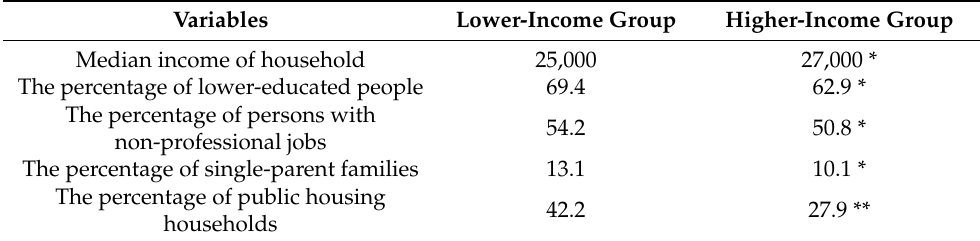
Table 4. Comparison of exposure index between lower- and higher-income older adults. Variables Lower-Income Group Median income of household The percentage of lower-educated